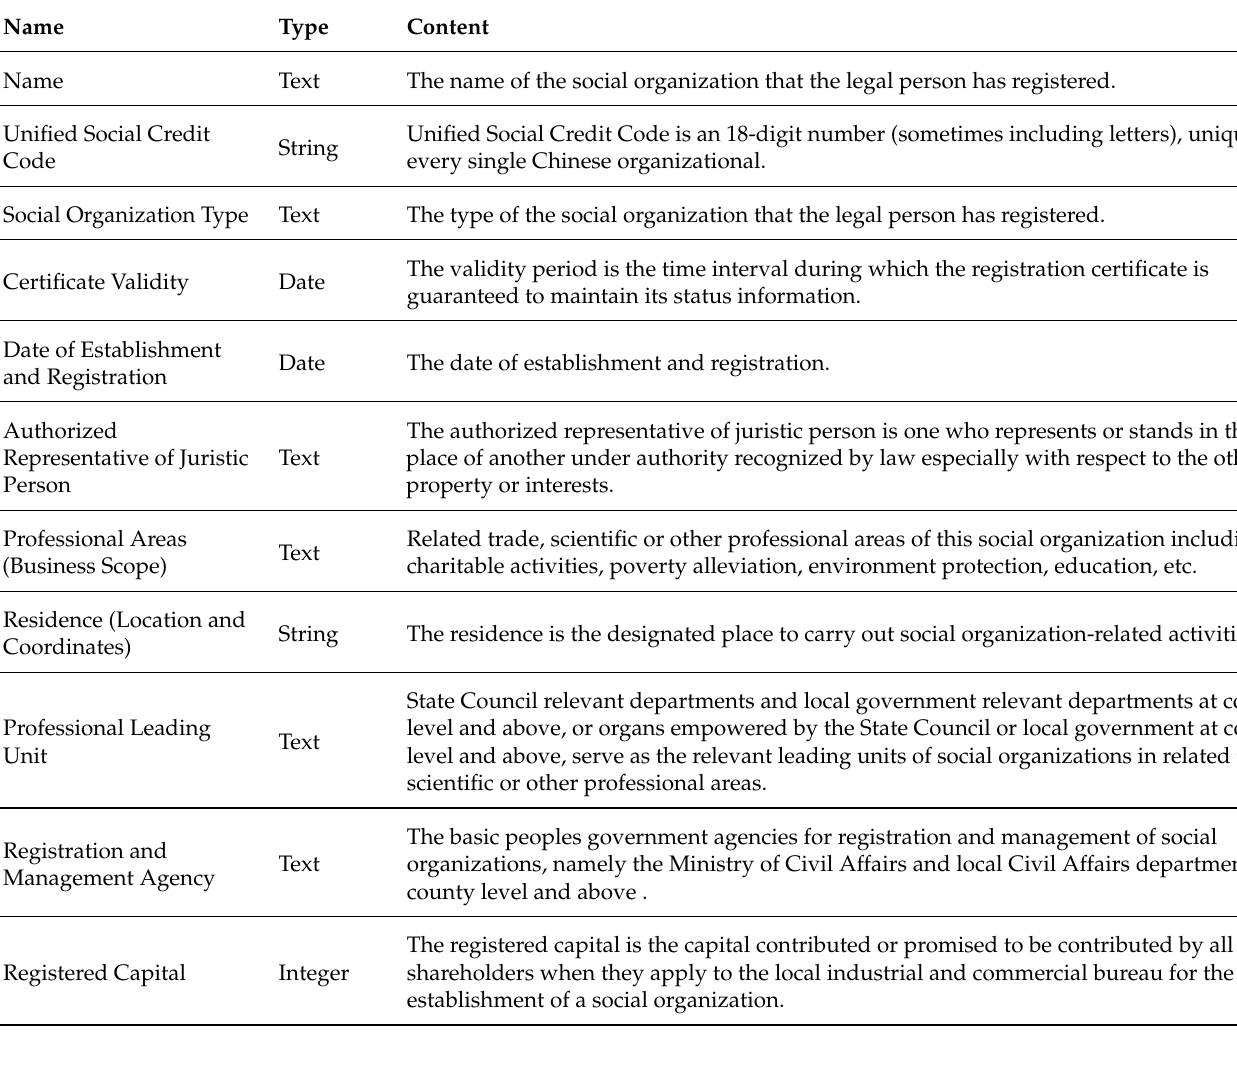
Table 1. The detailed elements published in the platform can be used as the basic variables that constitute the database.